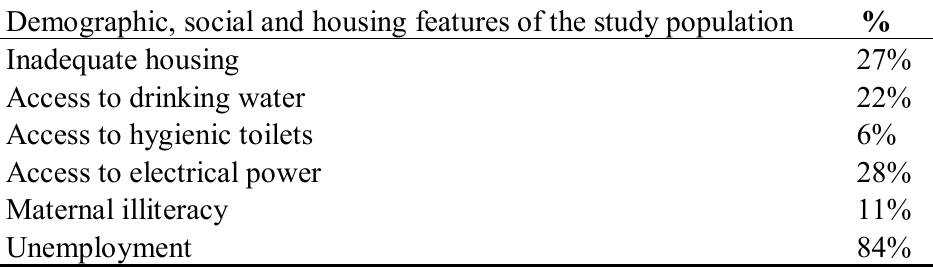
Table 1. Demographic, social and housing features of the study